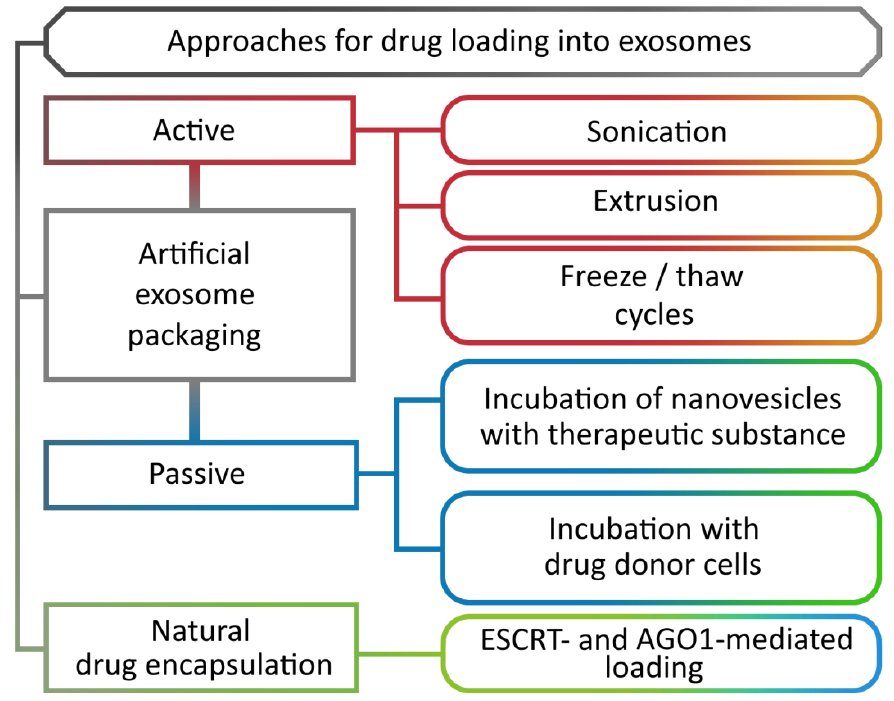
Figure 3. Methods for loading biomolecules into nanovesicles.